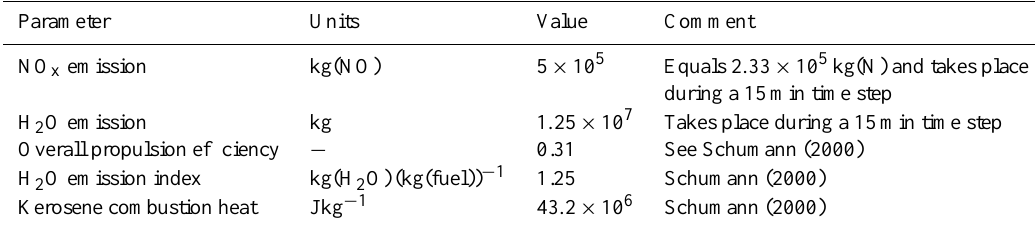
Table 3. Emissions and aircraft/fuel parameters.